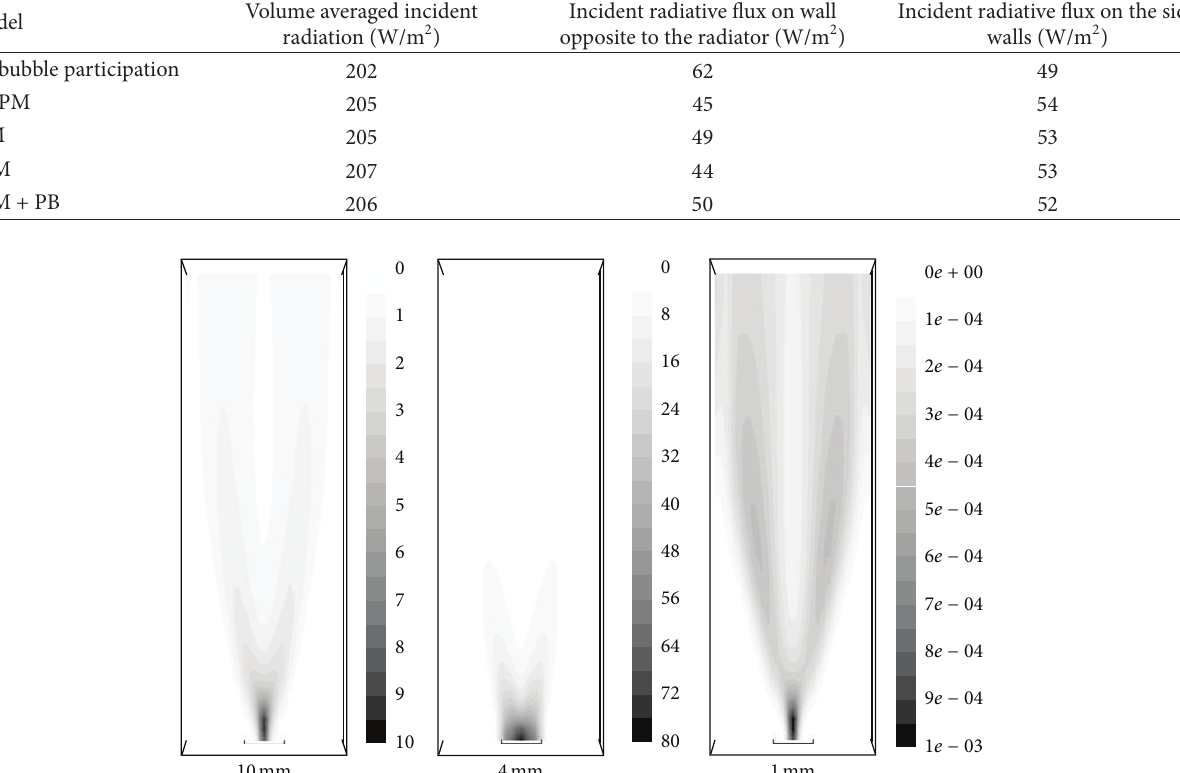
Table 2: Summary of radiative transfer calculations at inlet air velocities of 7.84 cm/s and inlet bubble diameters of 4 mm.